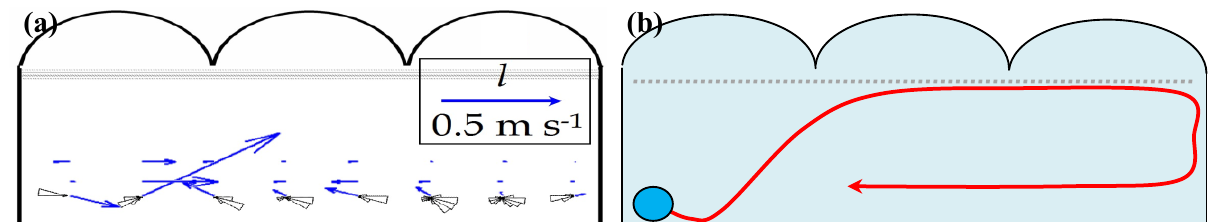
Figure 7. ( a ) Two-dimensional resultants of air velocity in the XZ plane ( v ) and polar plots of airflow direction in measurement test 2 (measurement line 2). ( b ) Approximate representation of the inside